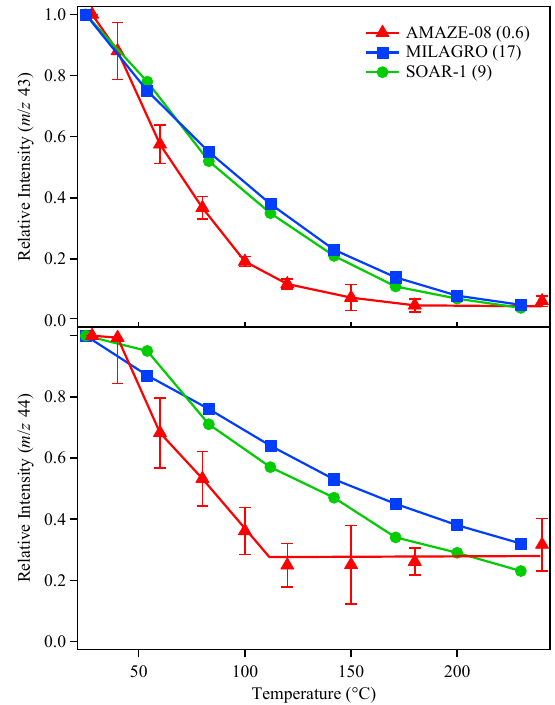
Fig. 13. Thermograms showing the relative signal intensity at m/z 43 (C 2 H 3 O + ) in the top panel and m/z 44 (CO 2 + ) in the bottom panel for the organic component of the particle mass spectra on 13 March 2008. Signal intensity is for unit mass resolution. The thermograms were corrected for diffusion losses inside the thermodenuder using the approach described by Huffman et al. (2008). The ambient-temperature flow rate through the thermodenuder was 0.6 Lpm. Thermograms for aerosol sampled during the MILAGRO and SOAR campaigns (Huffman et al., 2009b), which represent two polluted megacities, are also included in the figure. The numbers inside the parentheses in the figure legend indicate the organic mass loading (µg m − 3 ) of each measurement prior to thermodenuder treatment. The lines in the figure are to guide the eye and do not represent a model fit.